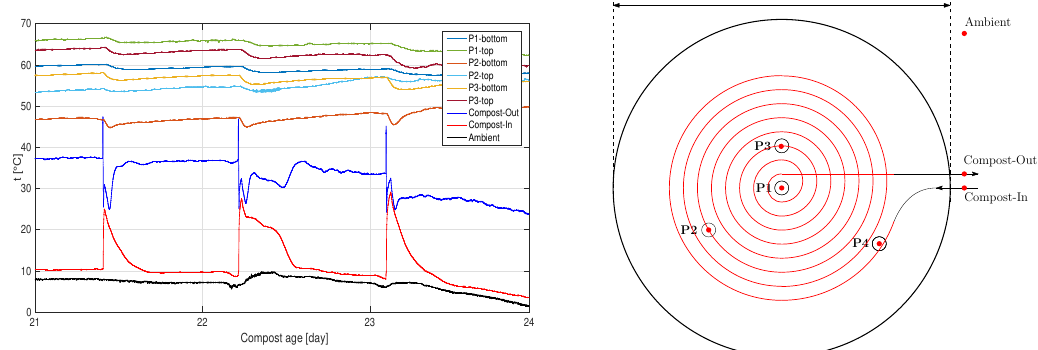
Figure 1. ( Left ) Temperature profiles at various points inside the mound; inlet and outlet water; ambient temperature. ( Right ) Position of measuring poles (P1–P4) with sensors and schematic drawing of the spiral heat